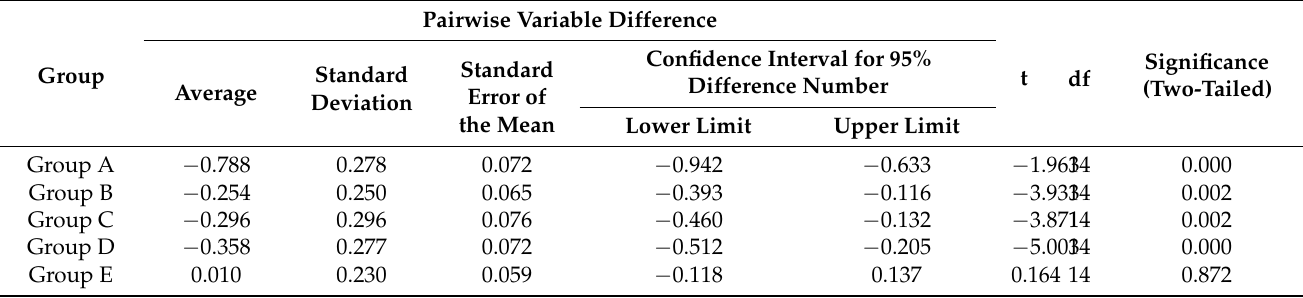
Table 3. The overall pre- and post-test dependent sample t -test checklist for the “physical and mental health” of the elderly in the community.